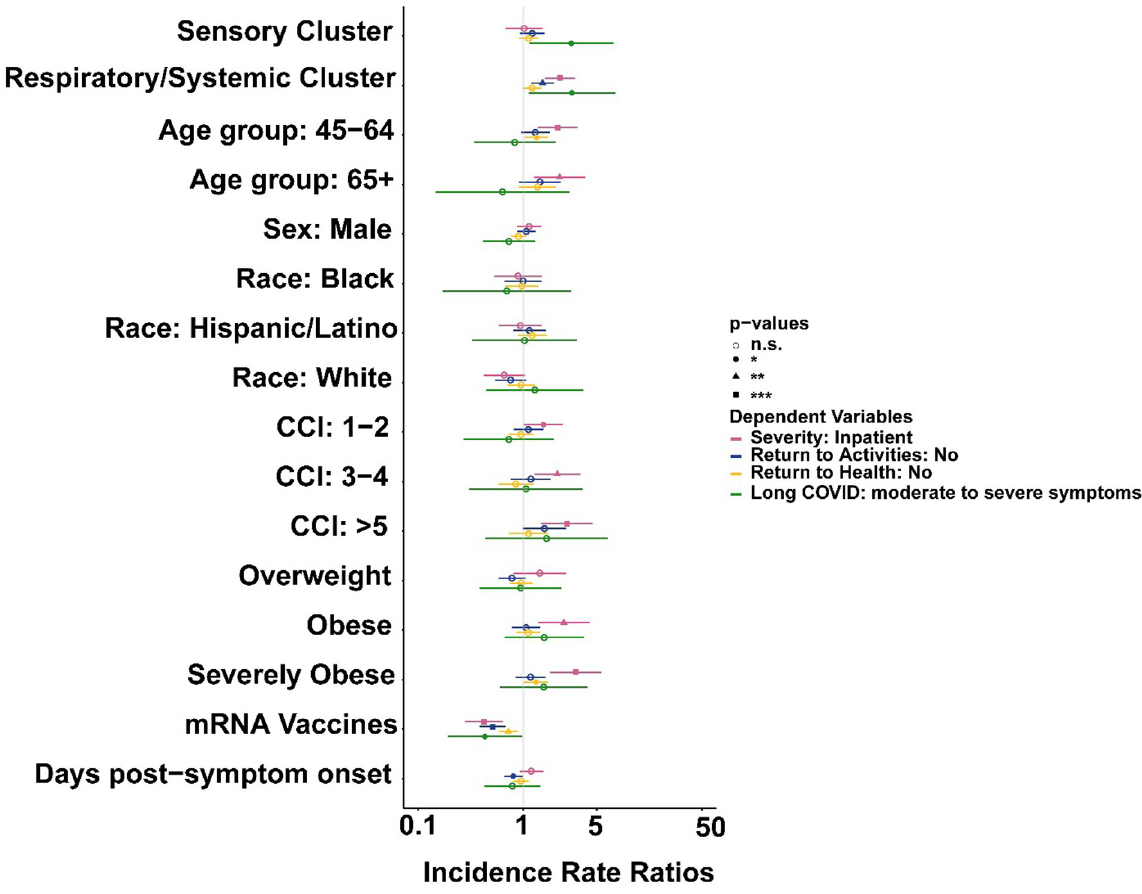
Fig 2. Multivariable Poisson regression model results from four distinct models: Disease severity ( pink ), failure to return to usual activities ( blue ), failure to return to usual health ( yellow ), and Long COVID ( green ). Whiskers representing 95% confidence limits.